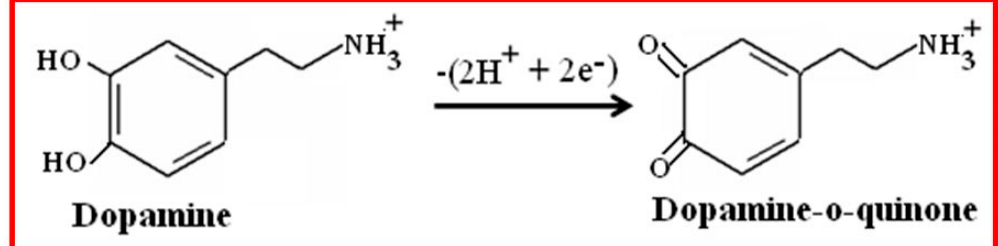
Figure 9. Differential pulse voltammetry (DPV) responses obtained for various concentrations of DA (0.1 µM to 0.105 mM) in 0.1 M phosphate buffer (pH 7.4) at a fixed scan rate 50 mV/s ( a ) CuO nanowires/GCE and ( b ) calibration curve plotted versus oxidation current and the molar concentration of dopamine (DA). The result indicated that anodic oxidation current successively increased with the increasing concentration of DA in the PBS, which proves the electrocatalytic response of the modified electrode for DA sensing is highly concentration dependent [49]. This type of immediate response on the electrode implies that the material (CuO nanowires) efficiently provides the well-defined voltammetric signals by promoting the redox behavior of DA. Figure 9b illustrates the relationship between the different concentrations of DA and the corresponding anodic peak currents, with a correlation coefficient of 0.9960. The obtained result indicates that the detection of very low concentrations of DA is possible on the CuO nanowires/GCE and the proposed biosensor showed a wide linear range of DA from 0.1 µM to 0.105 mM, with an acceptable sensitivity and limit of detection of 0.1 µM. The oxidation current response became saturated at a concentration of 0.10 mM, which may be accredited to the availability of a large number of nanowires with higher